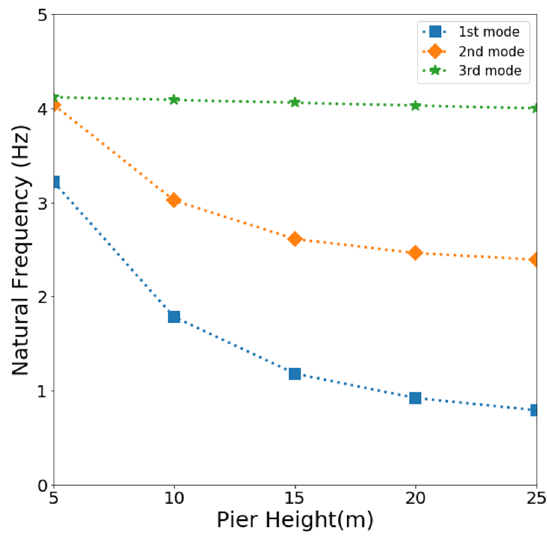
Figure 8. Change in the natural frequencies of the bridge with increasing height of the pier.